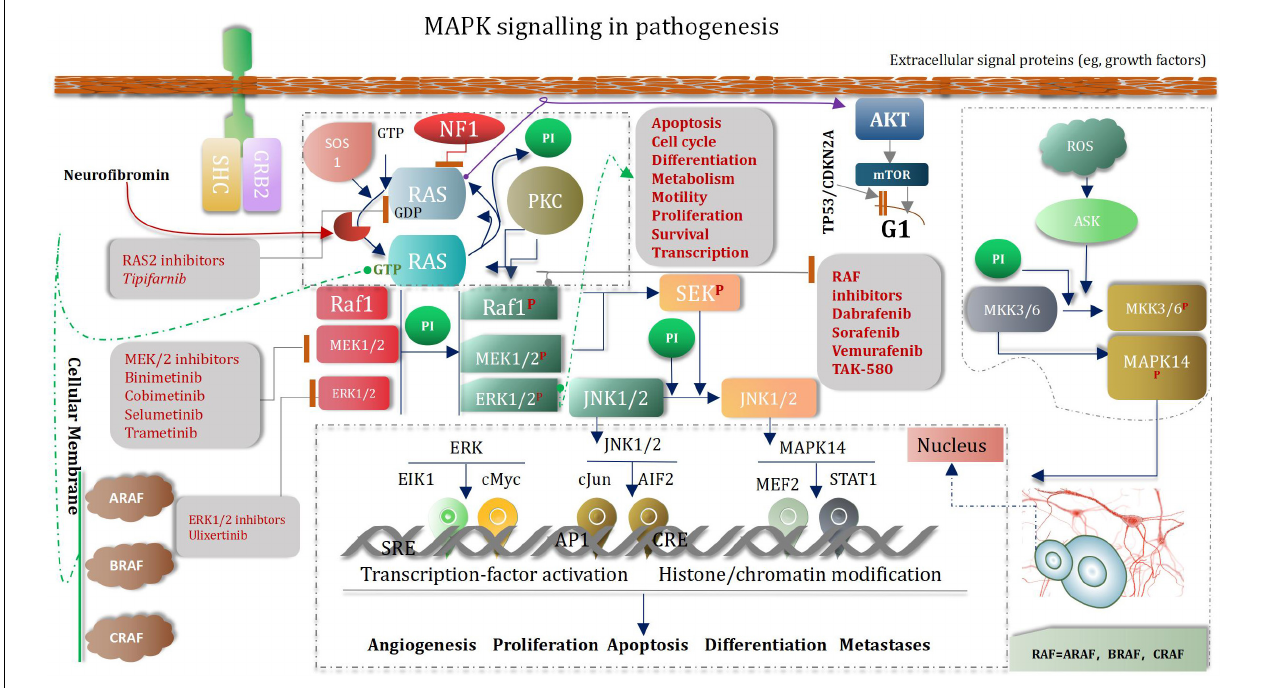
FIGURE 11 | MAPK signaling pathway.